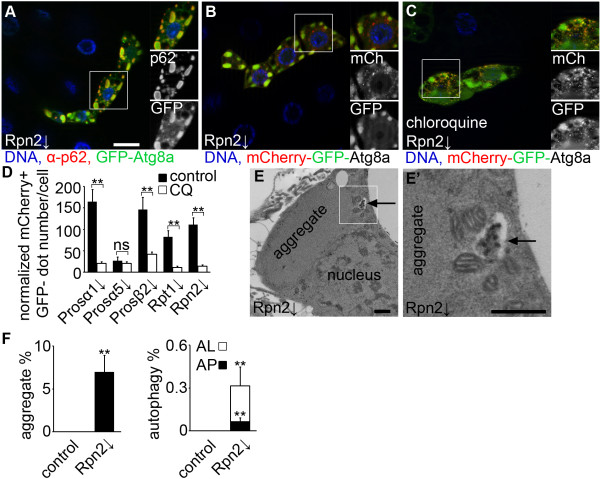
Proteasome impairment leads to accumulation of cytoplasmic aggregates and enhances autophagic flux. A) Overexpressed GFP-Atg8a reporter is incorporated into the large protein aggregates containing p62 in Rpn2 RNAi cells. B) The tandemly tagged mCherry-GFP-Atg8a reporter forms numerous small mCherry-labeled autolysosomes, in addition to large aggregates positive for both mCherry and GFP in Rpn2 RNAi cells. C) The lysosome inhibitor chloroquine blocks autophagy-dependent quenching of GFP, as now most puncta are positive for both mCherry and GFP. D) Quantification of data from panels B and C (u or t test, n = 5-8 per genotype, ** P < 0.01, * P < 0.05), and error bars denote standard error. E) Transmission electron microscopy reveals the presence of autolysosomes (arrow) and large protein aggregates in fat body cells with impaired proteasome function in well-fed larvae. The boxed area is shown enlarged in panel E’. F) Quantification of ultrastructural data. Protein aggregates occupy 7% of the total cytoplasm in Rpn2 depleted fat body cells of well-fed larvae, and double-membrane autophagosomes (AP) and degrading autolysosomes (AL) take up 0.06% and 0.24% of the total cytoplasm, respectively. No such structures are recognized in fat body cells of well-fed control larvae (u test, n = 3 per genotype, ** P < 0.01), and error bars denote standard error. Boxed areas in A-C are shown enlarged. Scale bar in A equals 20 μm for A-C. Scale bars equal 1 μm in E, E’.